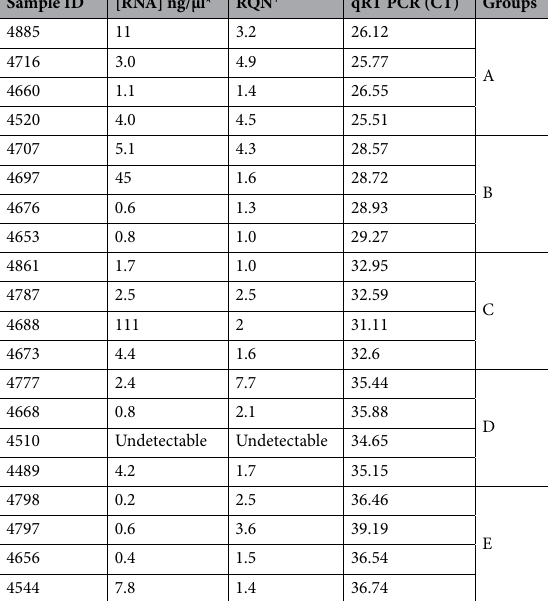
Table 1. Characteristics of patient nasal-swab samples. The 20 patient samples were grouped in 5 categories (A to E) according to their increasing average CTs. *Nanodrop 1000 and Fragment